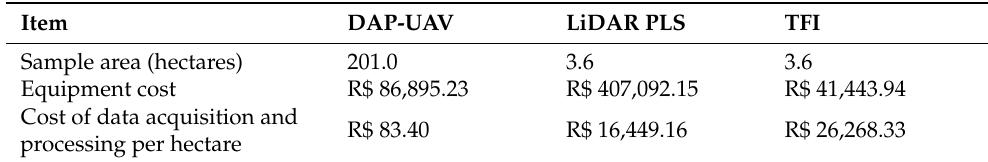
Table 15. Equipment cost and cost per hectare for data acquisition using DAP-UAV, LiDAR PLS, and